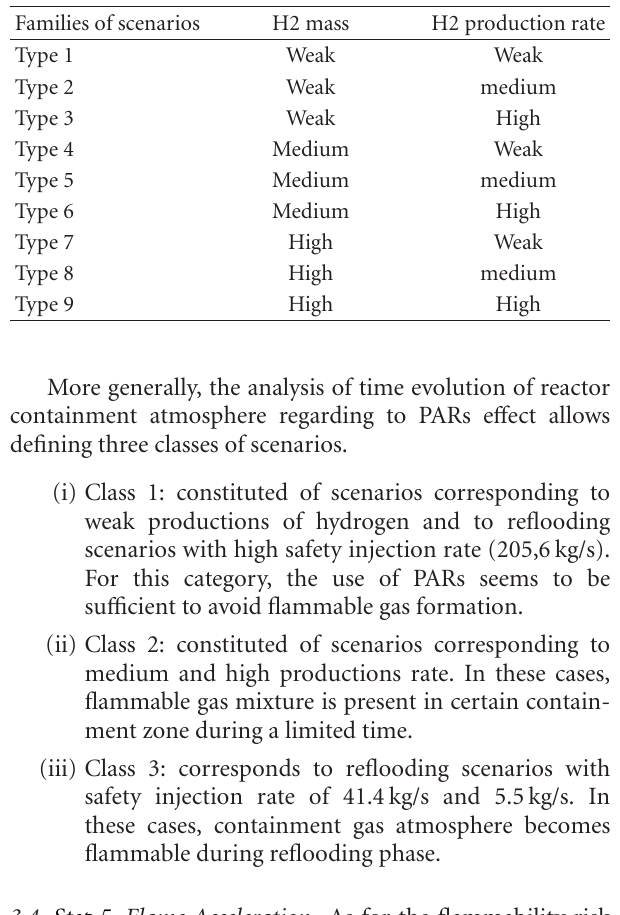
Table 1: Families of scenarios.